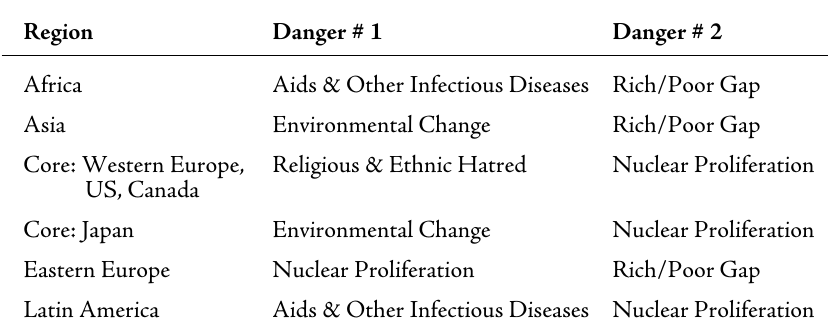
Table 2 – What Do Citizens Rank As the Greatest Danger Facing the